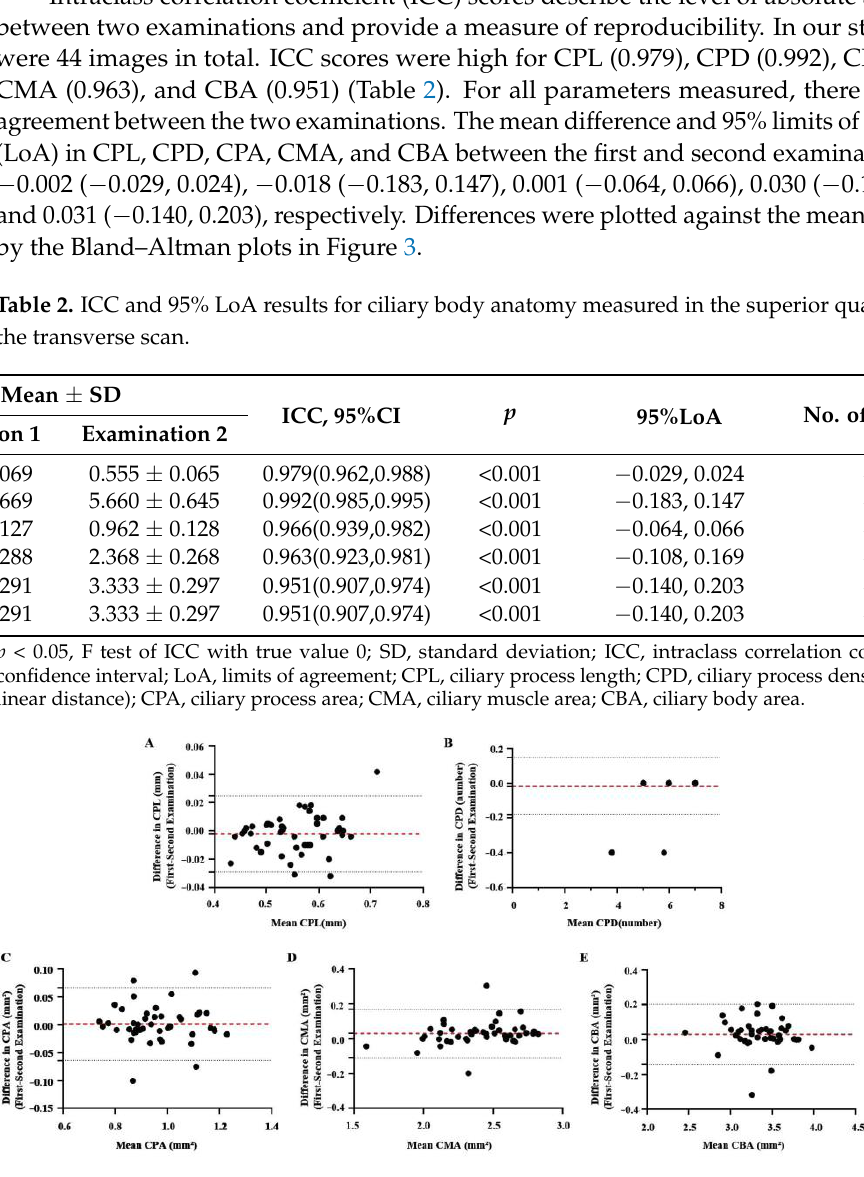
Figure 3. Bland – Altman plots for two repeat examinations of the superior CP. Differences for CPL ( A ), CPD ( B ), CPA ( C ), CMA ( D ), and CBA ( E ) generally fell within the repeatability coefficient limit (black dashed line), suggesting that the mean parameter was generally repeatable. The red dashed line shows the mean.